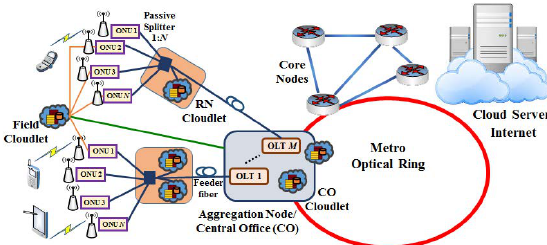
Figure 1. The hybrid cloudlet placement framework with cloudlets placed in the field, RN and CO of TDM-PON based FiWi